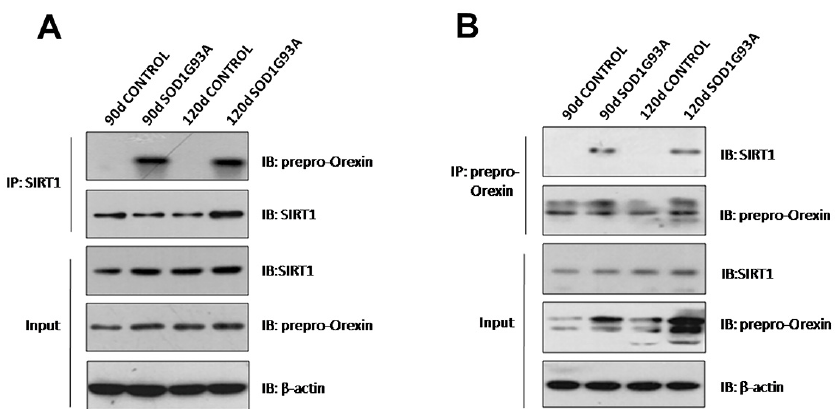
Figure 3. Co-immunoprecipitation confirmed that prepro-orexin interacts with SIRT1 in the hypothalamus in SOD1G93A transgenic mice. ( A ) Immunoprecipitation was performed using anti-SIRT1 antibodies. ( B ) Immunoprecipitation was performed using an anti-prepro-orexin antibody.